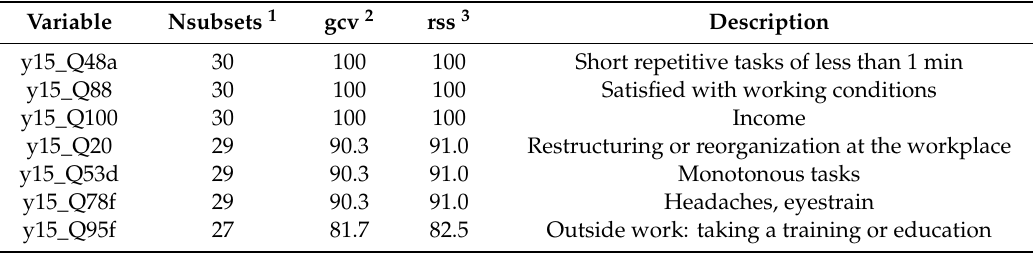
Table 4. Comparison of the performance of the proposed algorithm with two benchmark Table 5. A list of variables selected by the model as the most relevant to predict absenteeism among methodologies, linear regression (LR) and support vector machines (SVM). workers in the energy